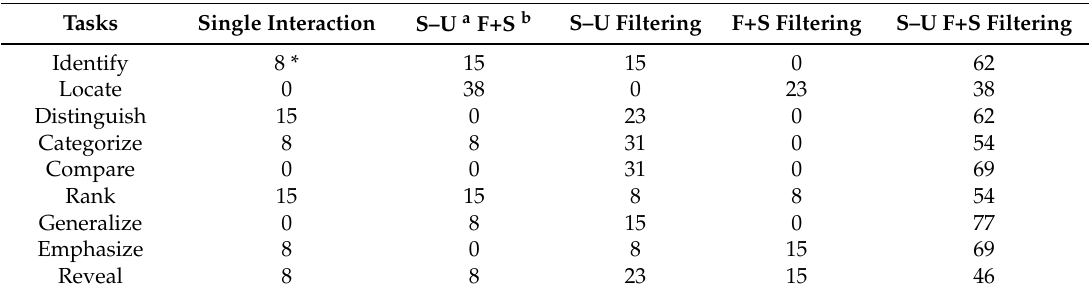
Table 3. Participants’ selection of interactions for completing some